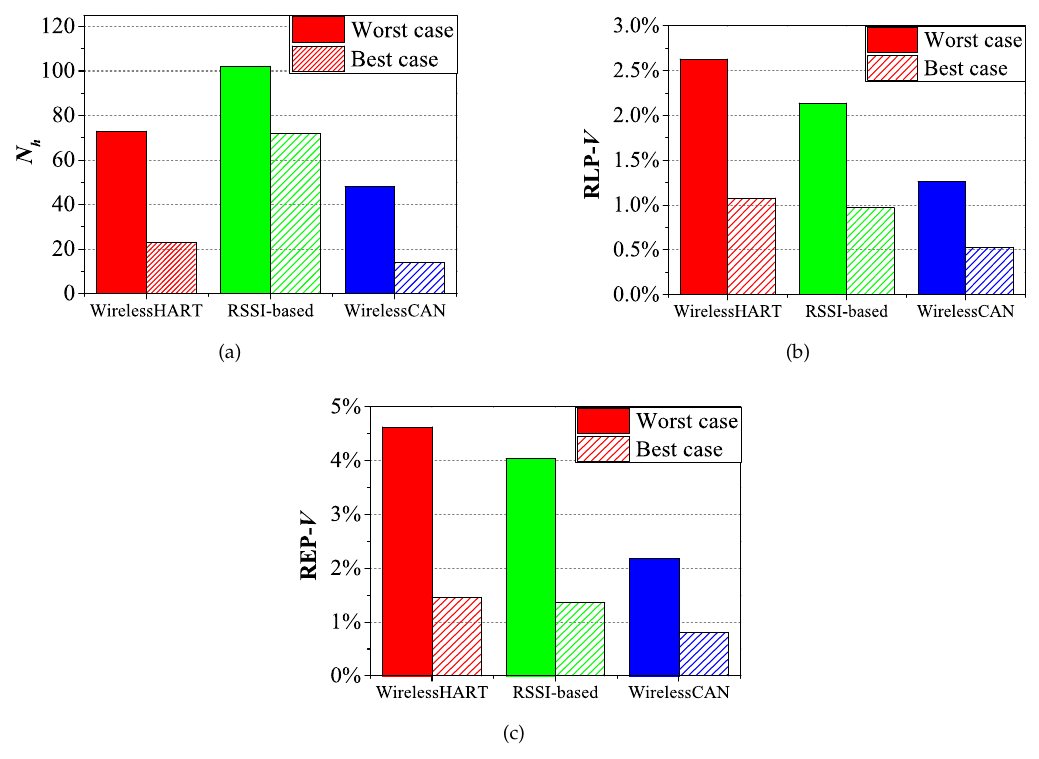
Figure 16. Comparison of RLP- V , REP- V and the number of handoff in practical implementation. ( a ) The number of handoff; ( b ) RLP- V ; ( c ) REP- V